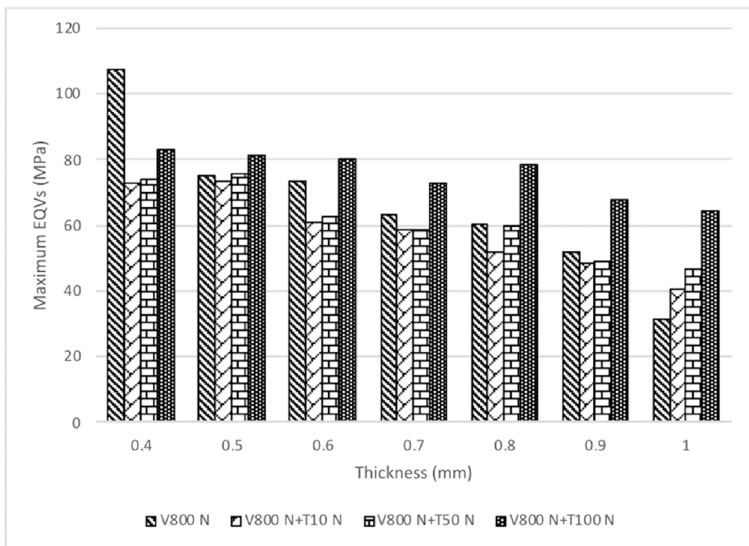
Figure 5. Comparison of von Mises stress values (EQVs) in zirconia specimens with seven thicknesses under vertical (V) 800 N, V 800 N + torque (T) 10 N, V 800 N + T 50 N, and V 800 N + T 100 N. The lowest value occurred when the thickness was 1.0 mm. V: vertical, T: torque.